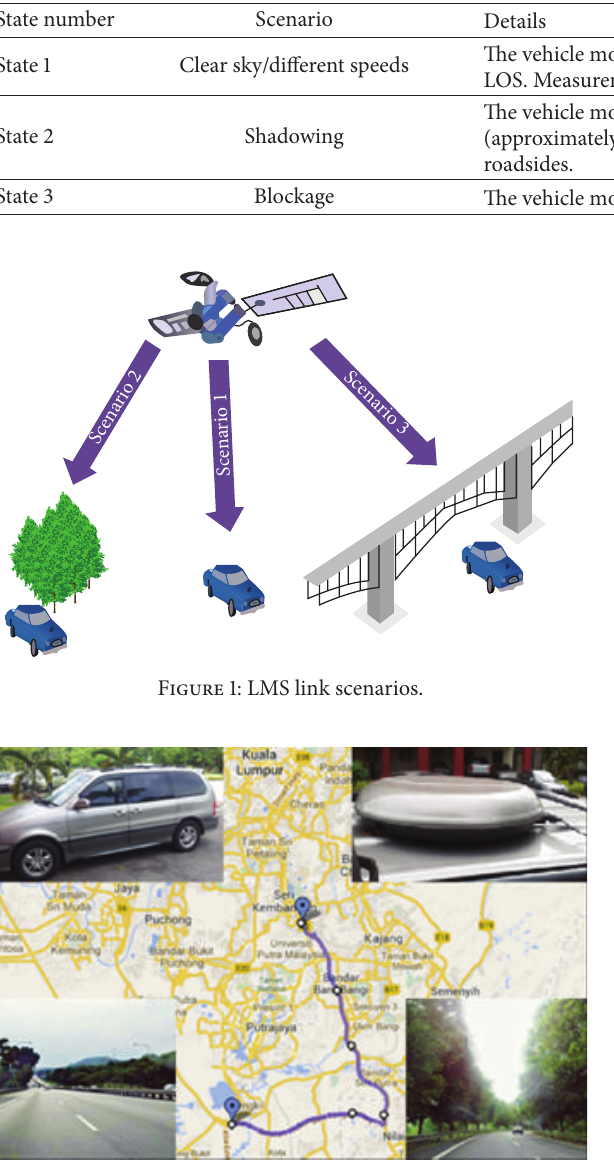
Figure 2: Measurements campaign.